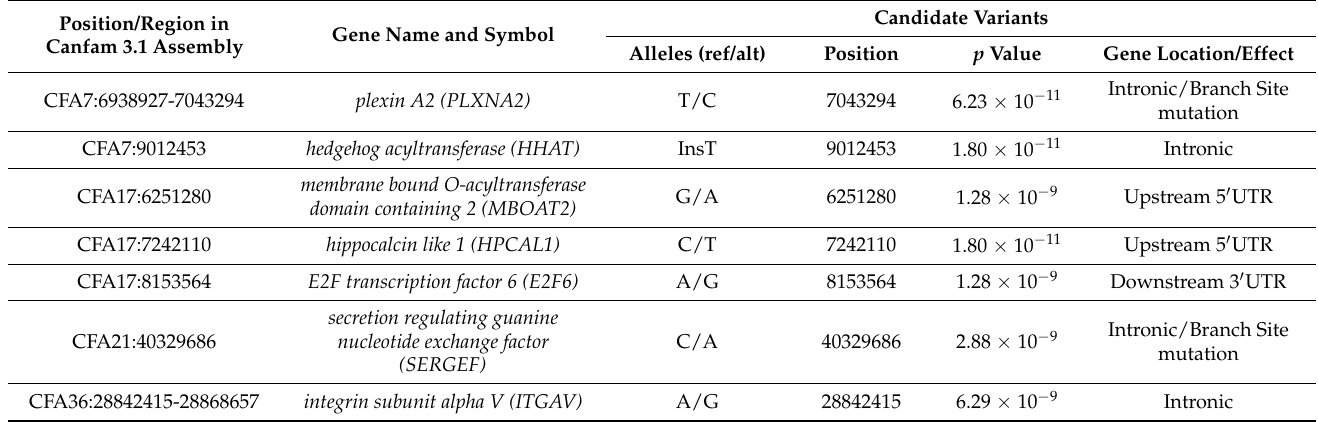
Table 2. Significant associations with the development of syringohydromyelia (SHM) in dogs.